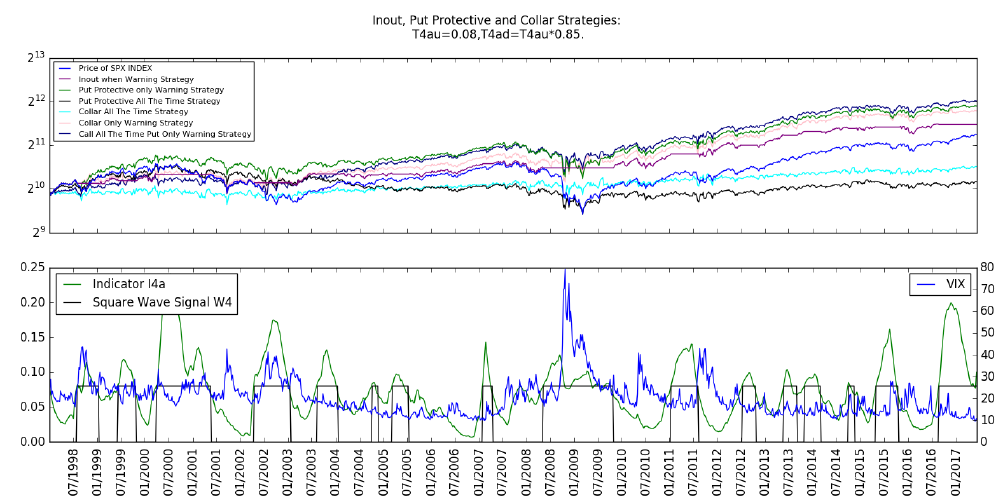
Figure 17. In-out, Put Protective and Collar Strategies based on W 4